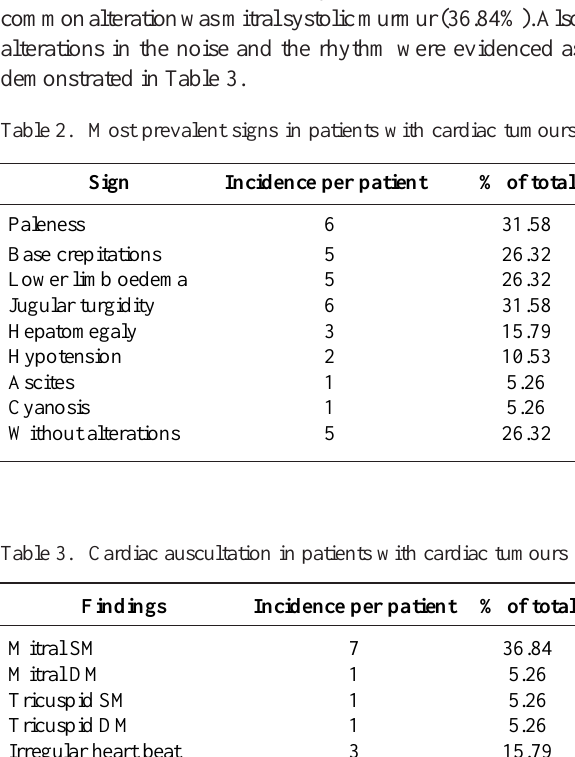
Table 4. Electrocardiogram in patients with cardiac tumours